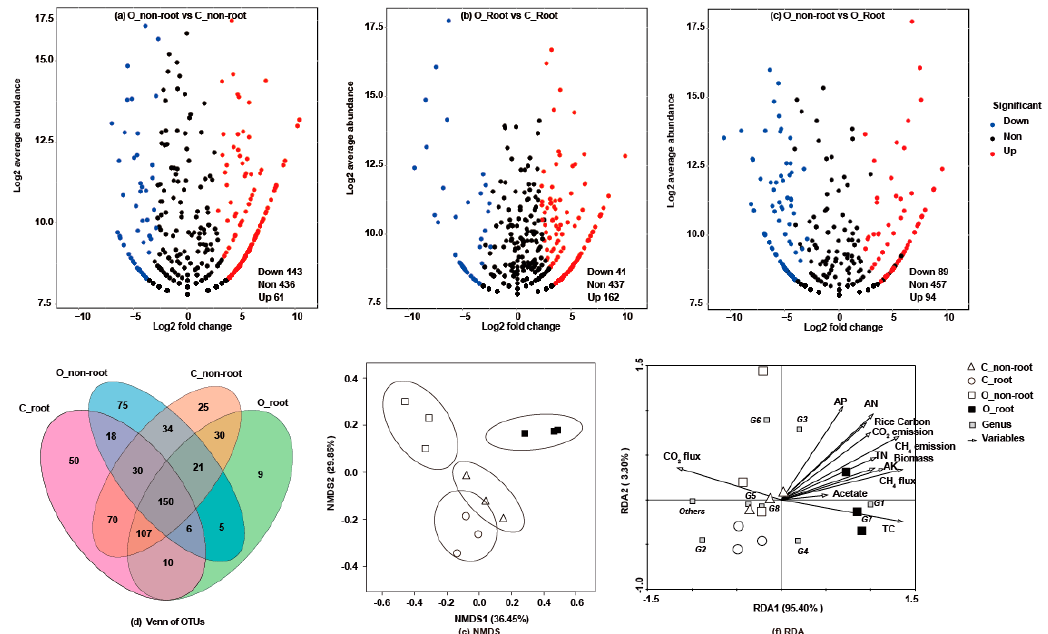
Figure 3. Profiles of soil samples from 16S rRNA sequencing. O_non-root, OTUs from the rice non-root soil of organic fertilizer treatment. C_non-root, OTUs from the rice non-root soil of no fertilizer treatment. O_root, OTUs from the rice root soil of organic fertilizer treatment. C_root, OTUs from the rice root soil of no fertilizer treatment. After sequencing, we obtained 645 series of OTUs. The volcano plots ( a – c ) illustrated that the OTUs were significantly enriched (red) and depleted (blue) for each sample. Each point represented an individual OTU, and the X -axis indicated the abundance fold change between two soil samples. Using the OTU abundance from the C_non-root soil or the C_root soil as the control and an adjusted p -value cutoff of 0.1, “down OTUs (Down)”, “up OTUs (up)” and “none down or up OTUs (None)” specifically represent OTUs that increase and decrease significantly in relative abundance from different soil samples, respectively. The Venn plot ( d ) involved four sets of ellipses: O_non-root, C_non-root, O_root, and C_root. Numbers within the diagrams indicated whether the OTUs were shared among treatments or unique to one given treatment. In addition, the Nonmetric Multidimensional Scaling (NMDS e ) analysis was performed to reveal the distances within the samples. The NMDS analysis is not affected by numerical sample distance and only considers the size of the relationship between each other. The RDA plot ( f ) was to analyze the correlations between the methanogenic community structure and variables. CO 2 flux, the CO 2 flux of the chamber in the whole system. AP, soil available phosphate. AN, soil alkali-hydrolyzable nitrogen. Rice carbon, the total carbon for rice plant. CO 2 emission, the CO 2 emission of the chamber in the whole system, calculated by the sum of CO 2 flux. TN, soil total nitrogen. Biomass, the dry weight of rice plant. AK, soil available potassium. CH 4 flux, the CH 4 flux of the chamber in the whole system. Acetate, soil acetate. TC, soil total carbon. δ 13 CH 4 , the δ 13 CH 4 abundance in the whole system. Soil δ 13 C, soil δ 13